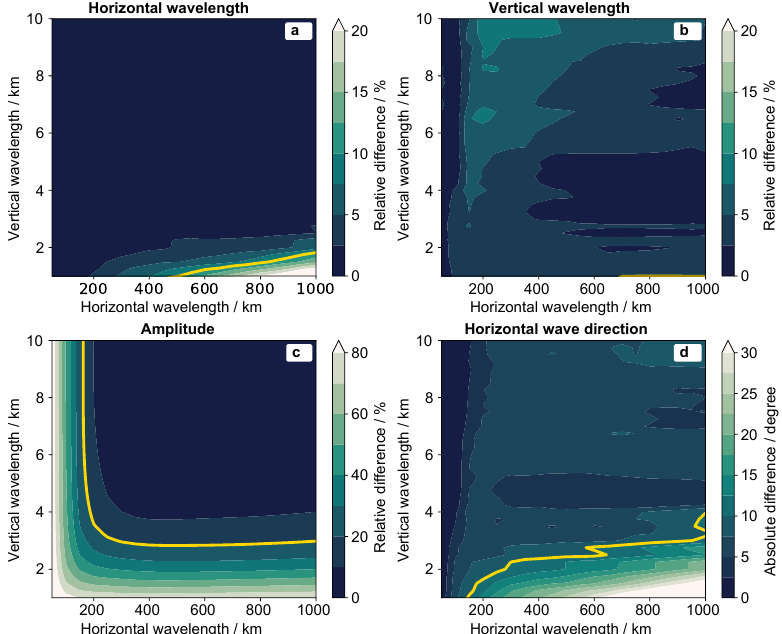
Figure 6. Specific observational filters for (a) horizontal wavelength λ h , (b) vertical wavelength λ z , (c) temperature amplitude ˆ T , and (d) hor- izontal wave direction ϕ for the LAT retrieval and synthetic horizontal wave orientation ϕ s = 180 ◦ and thus these waves have wavefronts perpendicular to the flight path. The yellow lines mark errors of 10%, 10%, 20%, and 10 ◦ in panels (a) – (d) ,